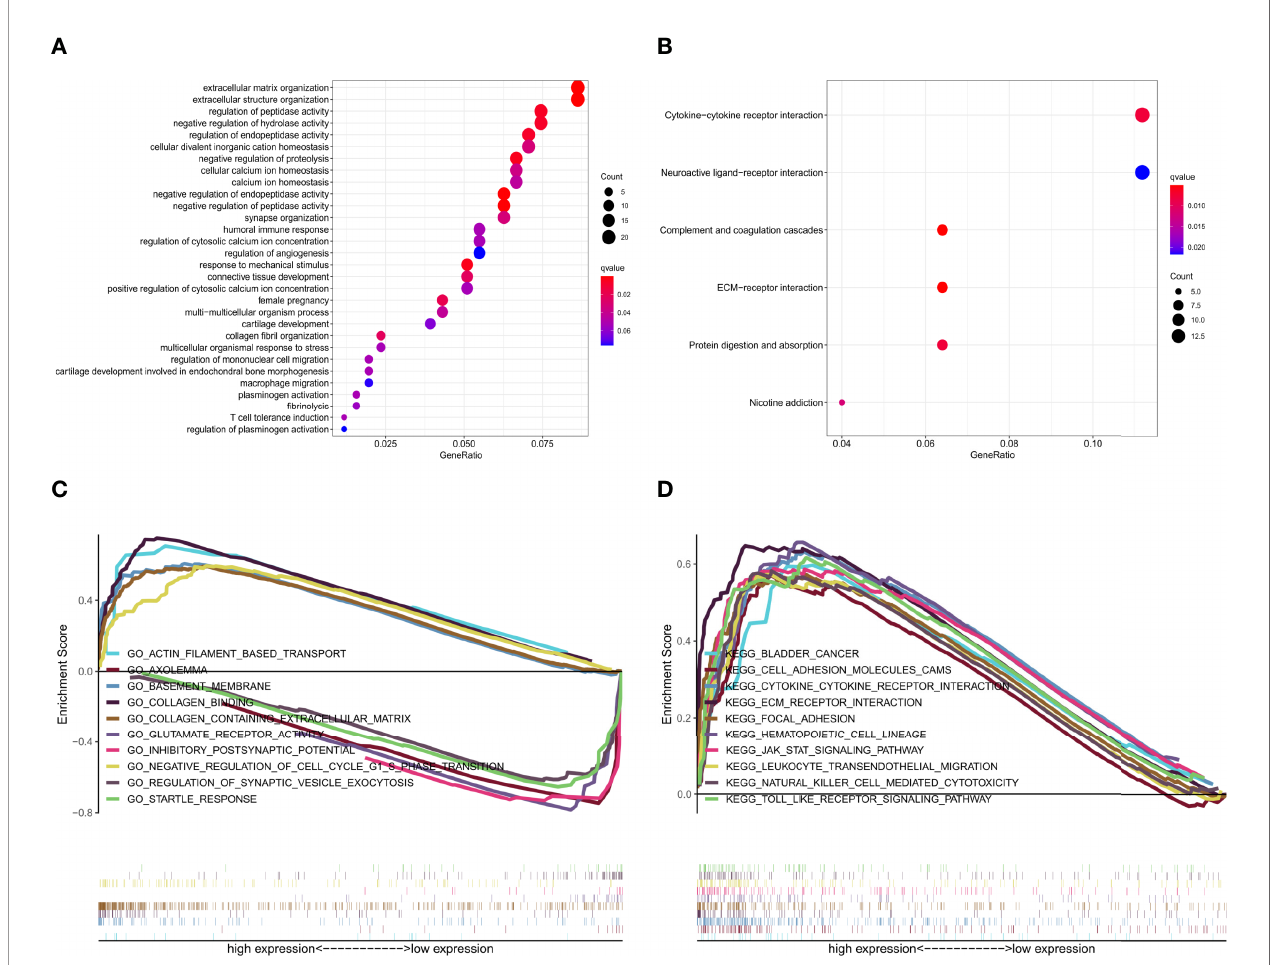
FIGURE 9 | (A) GO enrichment analysis of DEGs in GSE43378. (B) KEGG pathway enrichment analysis of DEGs in GSE43378. (C) GSEA GO enrichment analysis of genes in CGGA. (D) GSEA KEGG pathway enrichment analysis of genes in